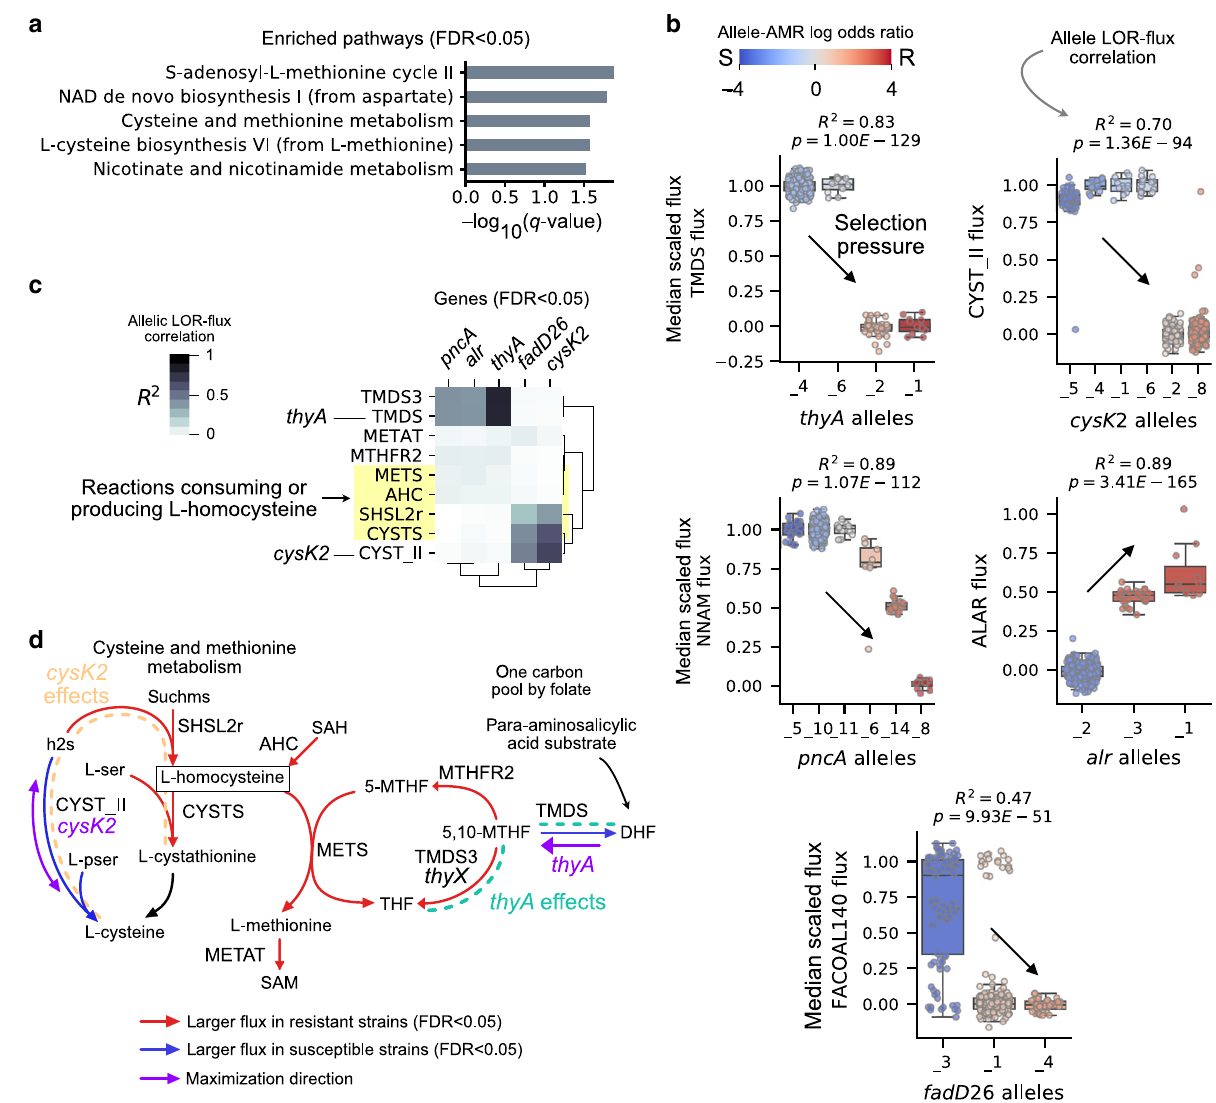
Fig. 4 Characterization of para-aminosalicylic acid MACs. a Horizontal bar plots of pathways enriched with signi fi cant para-aminosalicylic acid-associated fl uxes with FDR < 0.05. b Boxplots of thyA , cysK2 , alr , pncA , and fadD26 allele-speci fi c fl uxes for the reactions catalyzed by their gene-products. Alleles are rank ordered from least to greatest by their log odds ratio (LOR), from left to right. The boxes are colored according to the allele LOR, where positive corresponds to resistant (R) dominant while negative corresponds to susceptible (S) dominant. The box shows the quartiles of the dataset with the median noted as the horizontal line while the whiskers extend to show the rest of the points with outliers colored gray. The R -squared and P -value for the regression between allele LOR and fl ux is noted. See Supplementary Data 4 for list of mutations per allele. c Clustered heatmap of allele LOR- fl ux correlations for signi fi cant reactions in cysteine and methionine metabolism. d Pathway depiction of cysteine and methionine metabolism and one carbon pool by folate. Signi fi cant allelic effects are shown by dashed lines and colored for thyA and cysK2